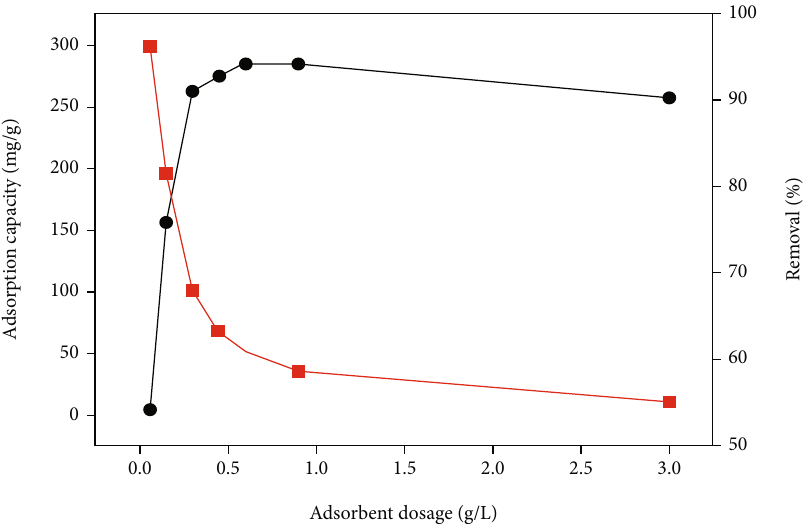
Figure 7: The impact of dosage of adsorbent employed in this study (condition: initial MGconcentration = 0 : 03mg · L − 1 , contacttime = 150 min , temperature = 303 : 15K , and shakingspeed = 200rpm ).